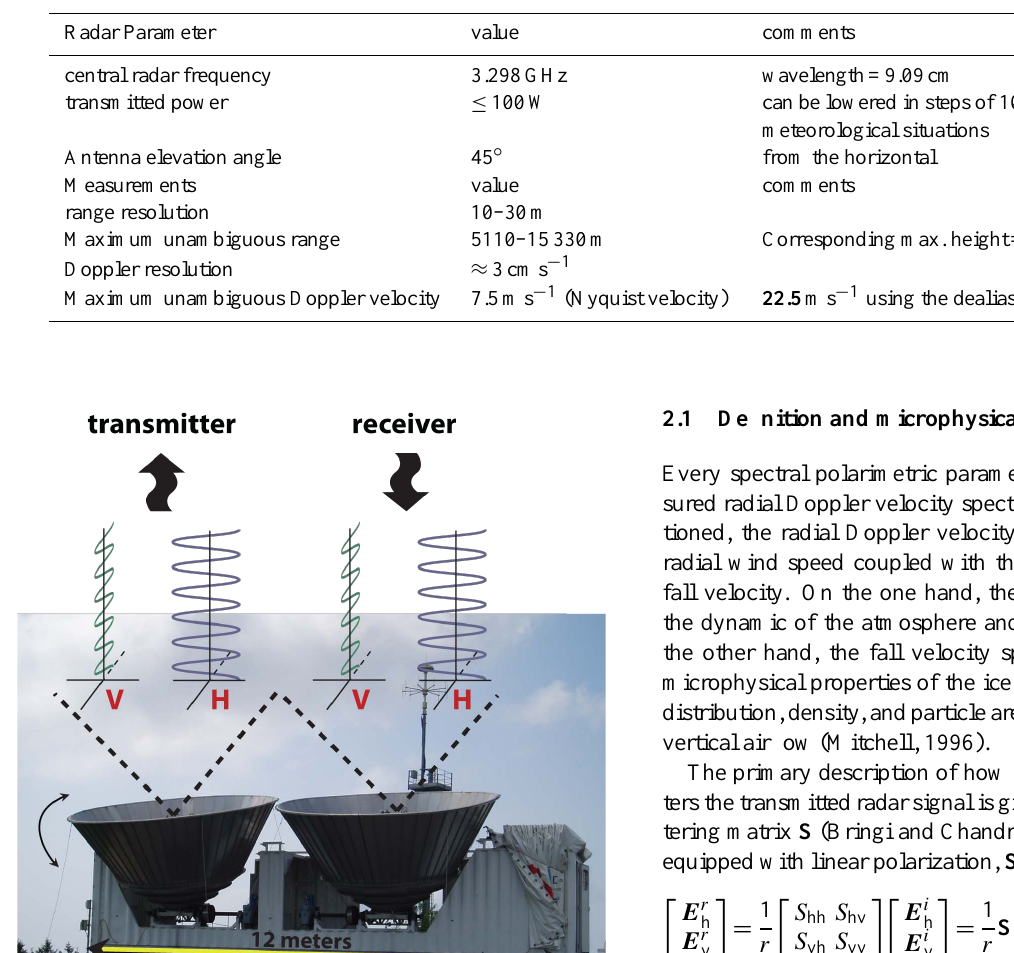
Table 1. Standard TARA specifications used for cloud microphysics measurements.